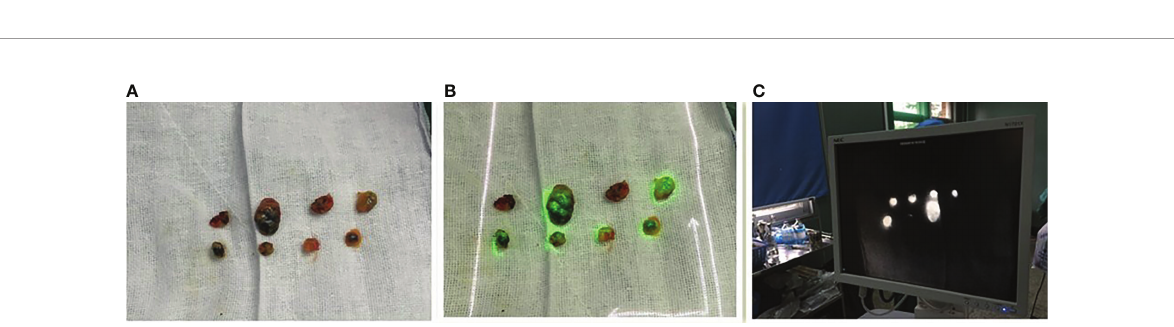
FIGURE 3 | Intraoperative fl uorescence imaging of lymph nodes. (A) Left one: Intraoperative fl uorescence imaging of lymph nodes with the LFIS. (B) Right one: Intraoperative fl uorescence imaging of lymph nodes with the Langfang Vascular imager.